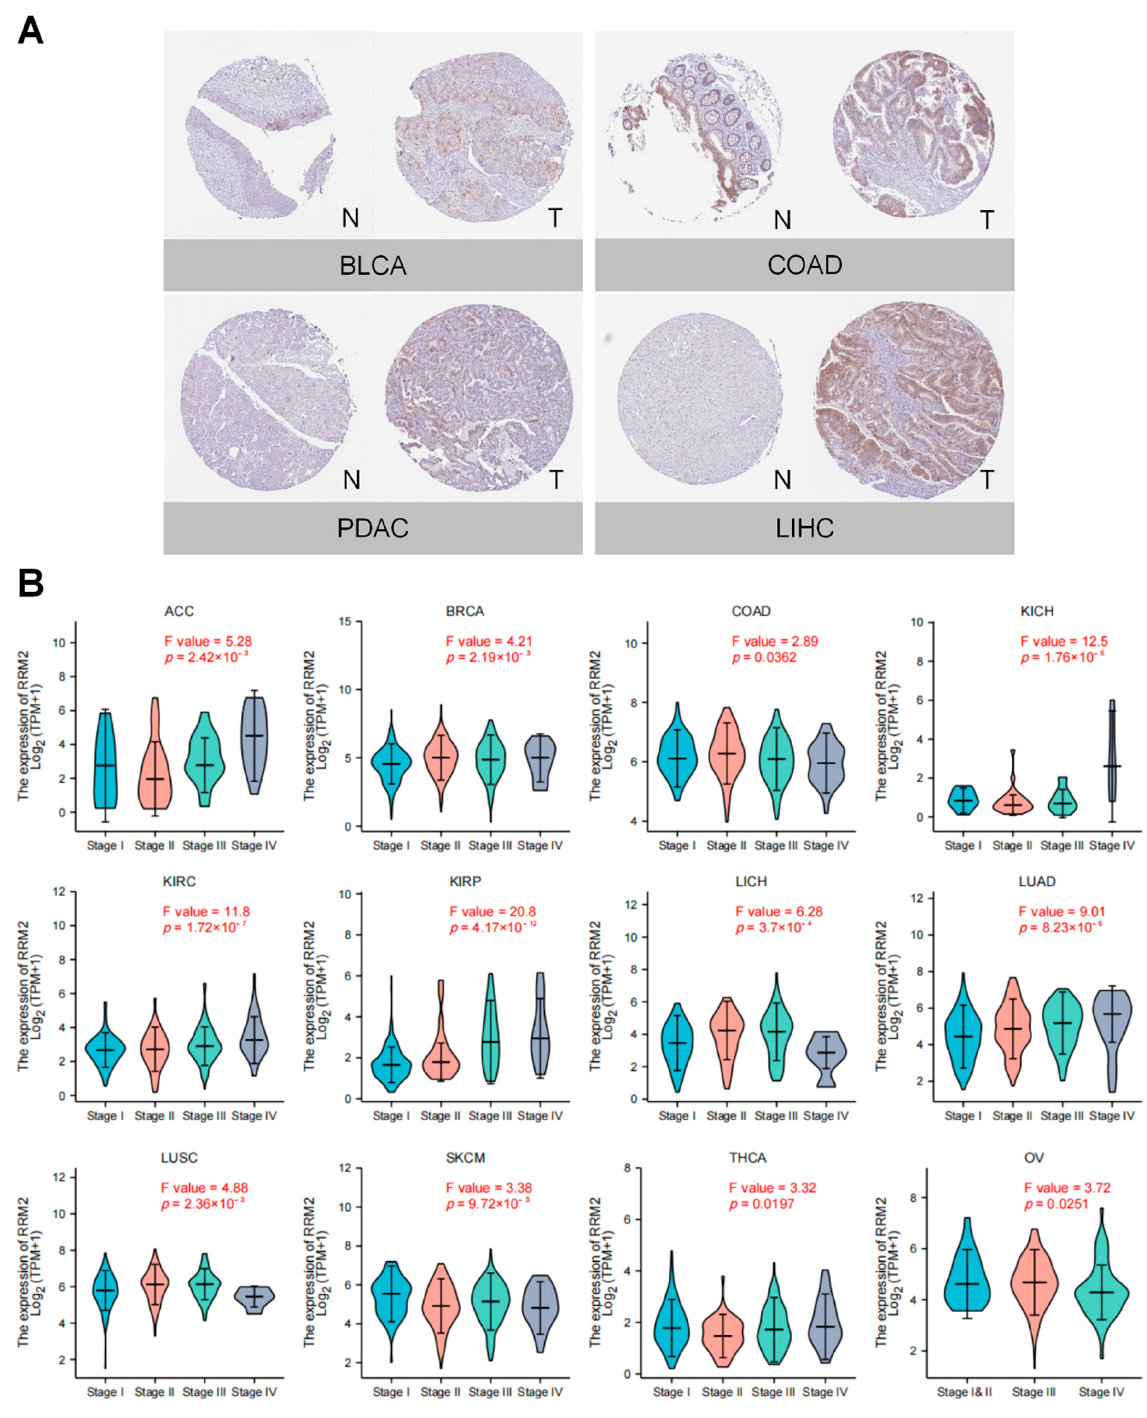
Figure 2. RRM2 Expression and clinical Features. ( A ) IHC images of RRM2 in pan-cancer. The figures were obtained from HPA database (https://www.proteinatlas.org/, accessed on 25 February 2022). ( B ) Correlation between RRM2 expression and tumor stages in pan-cancer analyzed in TCGA